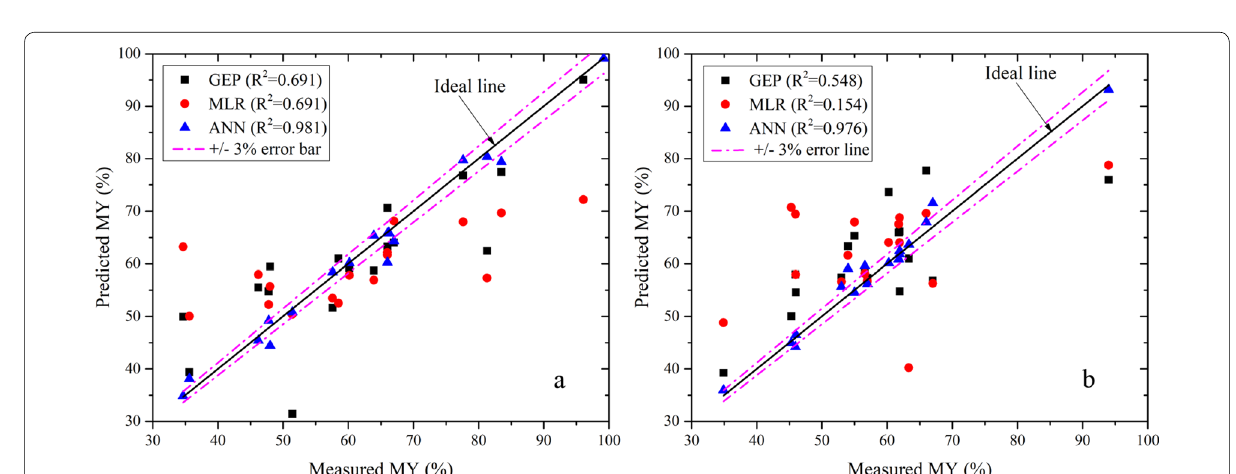
Fig. 8 Model comparison for the MY using a testing datasets, b validation